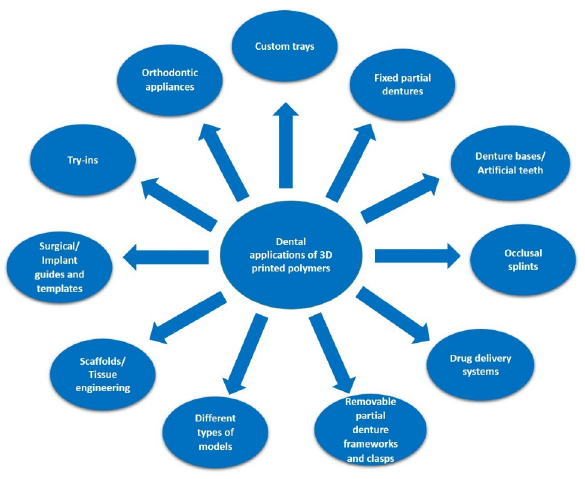
Figure 1. Indications of 3D-printed polymers in dentistry.